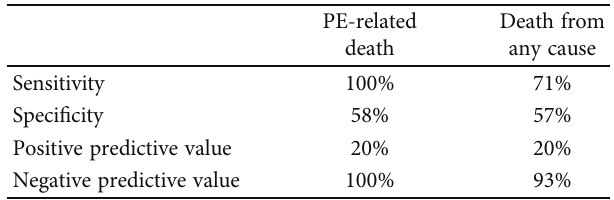
Table 5: TTE examination of RVD as a predictor of in-hospital